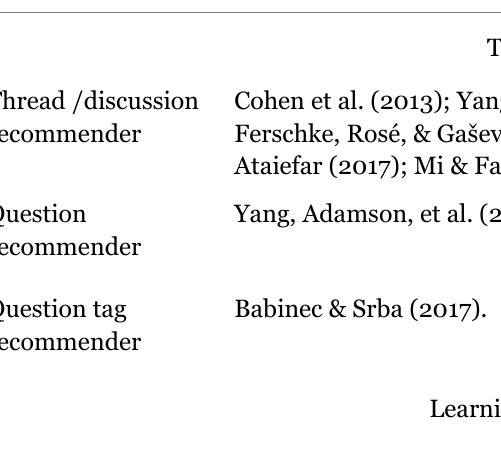
Distribution of Work in Recommender System